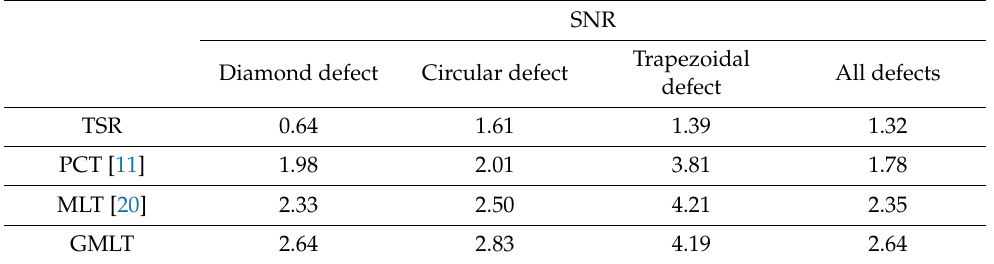
Table 1. Comparison of SNR values of various methods.